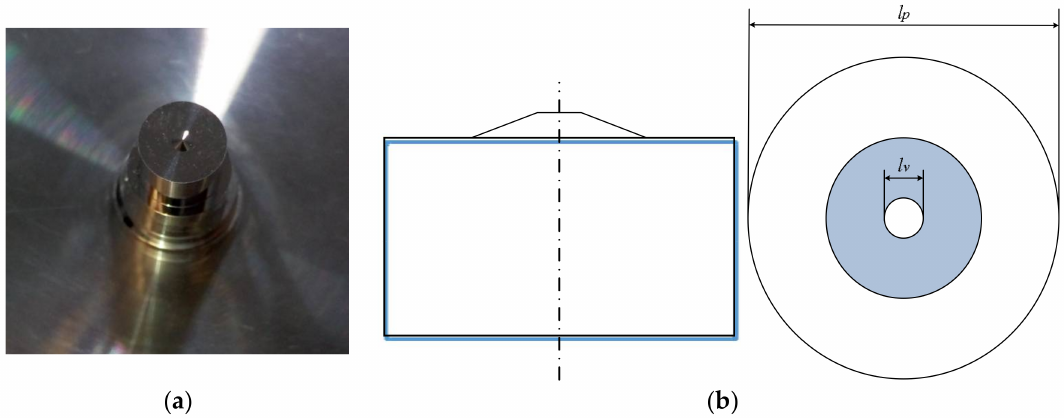
Figure 6. Geometries composite standard and computer-aided design (CAD) diagrams: ( a ) composite standard; ( b ) CAD diagrams of the